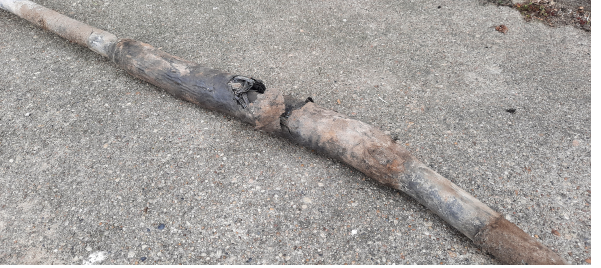
Figure 1. Example of damage to a cable joint mounted on a cable type XRUHAKXS 1 ×